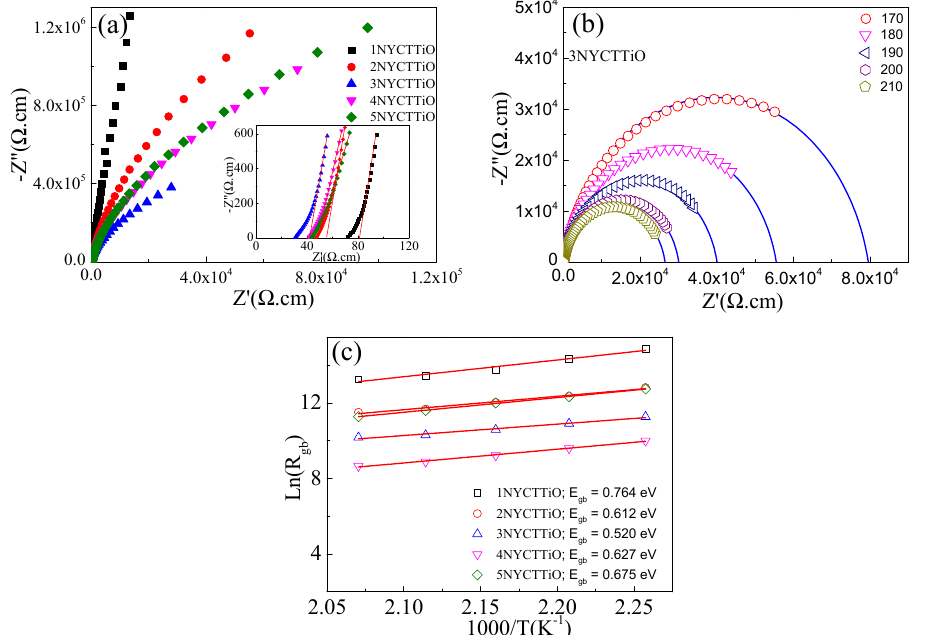
Figure 6. ( a ) Impedance complex plane plot at 20 °C and inset non-zero intercept of Na 1/2 Y 1/2 Cu 3 Ti 4.1 O 12 ceramics sintered at 1070 °C for 1, 5, and 15 h and sintered at 1080 and 1090 °C for 5h. ( b ) Impedance complex plane plot in the temperature range of 170–210 °C for the sample sintered at 1070 °C for 15 h. ( c ) Arrhenius plot of the grain boundary conductivity (R gb ).